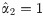
ATP production vs. substrate limits with high cost respiration.α1 = 1, α2 = 1, α3 = 50, Γ = 200, α^2=1 and v1 is capped by a value within the range [0, +∞). When the uptake of the substrate has limit greater than 100, it will not affect the ATP production and it remains as 200. As shrinking the constraint, the ATP production is linearly decreased until the limit reaches 3.92 in which v2 = 0, then the production is linearly decreased with a sharper speed until 117.6 when there is no net external substrate provided. The turning points are at (100, 200) and (3.92, 125.5).